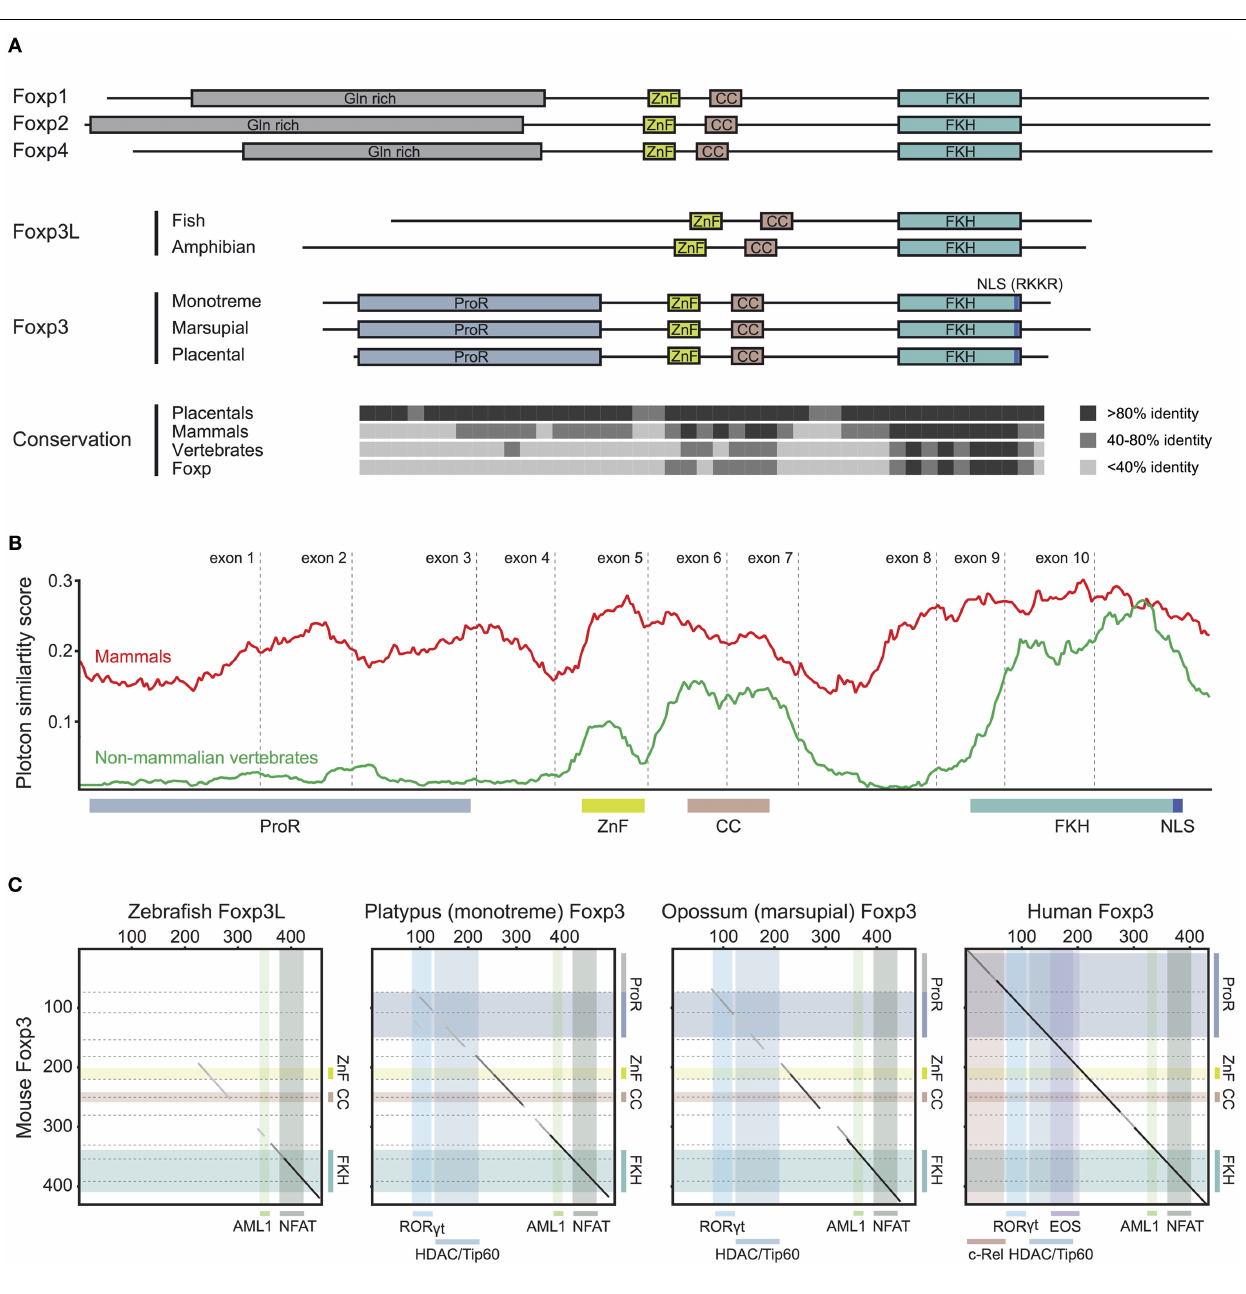
FIGURE 5 | Stepwise gain of Foxp3 domains. (A) Representative schematic of the functional domains of Foxp1, Foxp2, Foxp3, and Foxp4 that can be found in mammalian proteins. (ProR, Proline-rich region; ZnF, zinc finger; CC, coiled-coil; FKH, forkhead; NLS, nuclear localization signal. All domains are drawn to scale using mouse proteins).The conservation across the Fox family members is shown as the percent identity in windows of 10 amino acids over the length of mouse Foxp3 as compared to the placental (8 species), mammalian (10 species), and vertebrate (3 species) consensus as well as that of the mouse Foxp subfamily. (B) A conservation plot showing the average